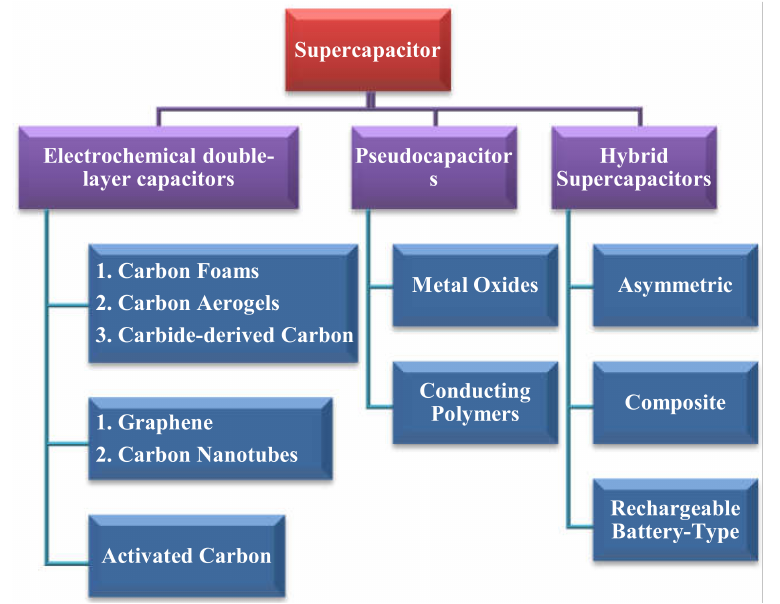
Figure 4. Overview of supercapacitor types and